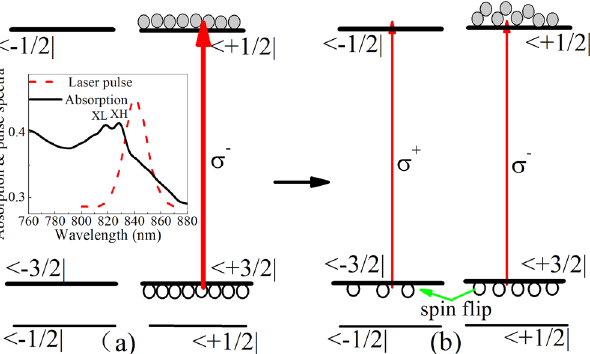
Figure 1. The schematic of band structure of intrinsic GaAs quantum wells. ( a ) Selective excitation of σ − circularly polarized pump pulses. ( b ) Selective detection of σ − and σ + circularly polarized probes. The inset in ( a ) shows absorption spectrum of the sample and power spectrum of femtosecond laser